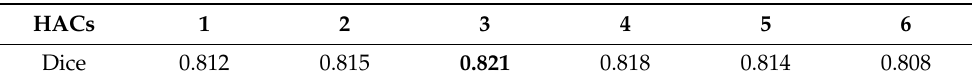
Figure 12. HAC effect: ( a ) input images, ( b ) M-Net, ( c ) U-Net, ( d ) RU-CBV-T, and ( e ) HRU-CBV-T (proposed). The red and yellow outlines superimposed on the input images denote the labels and segmentation result contours. Table 6. The effect with the increase of HAC module to the proposed network. The bold number denotes the best